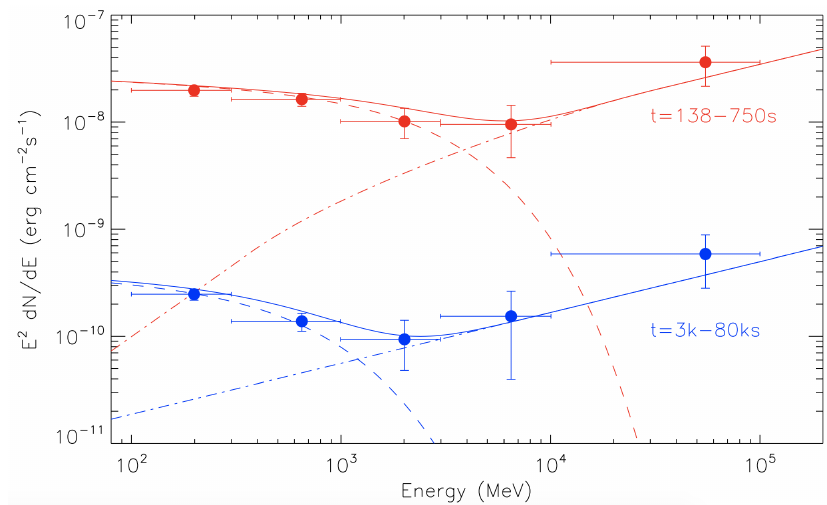
Figure 2. GRB 130427A: fit of the LAT spectrum at two different times. A modelling with a syn- chrotron component (dashed line) and an SSC component (dot-dashed line) was proposed to explain the spectral hardening at E > 5GeV. From